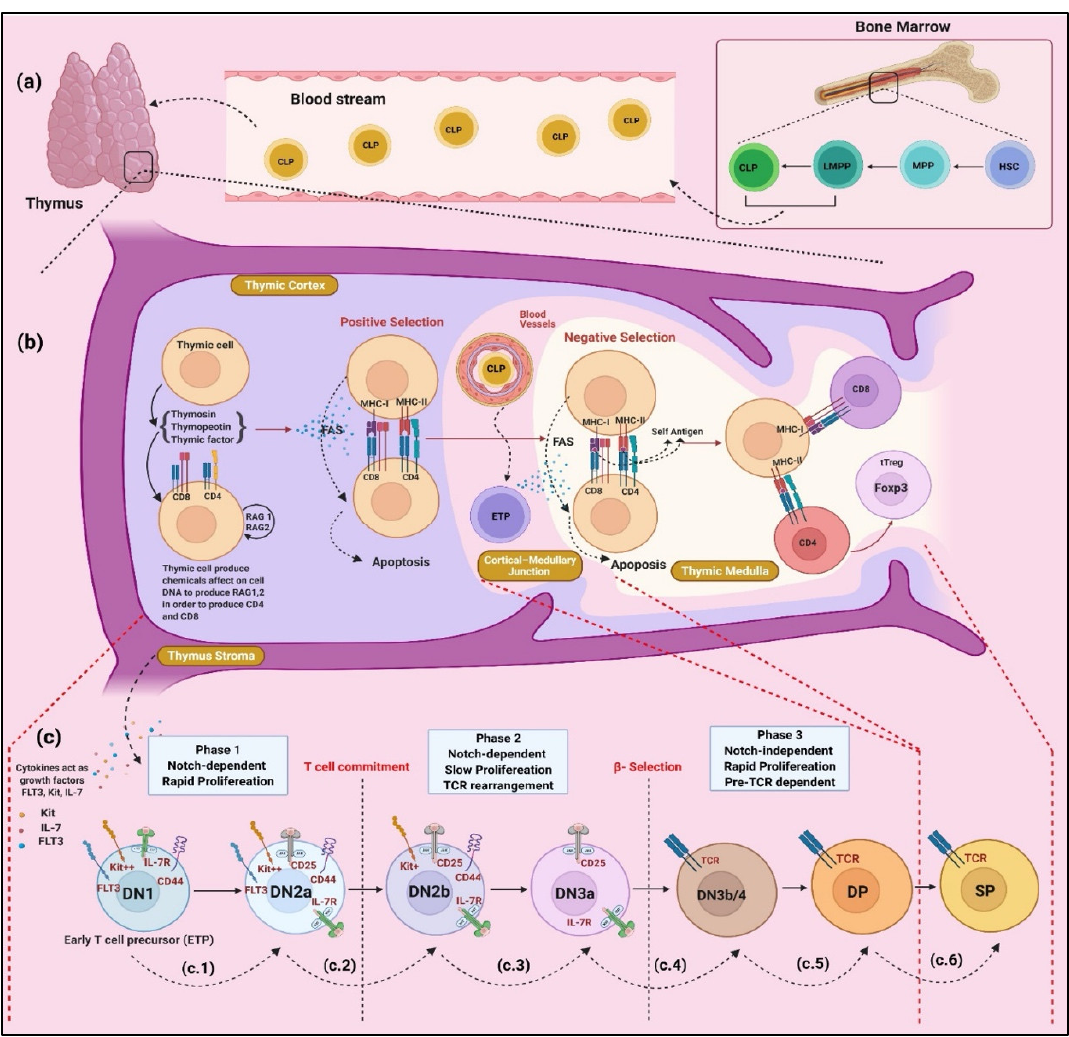
Figure 2. Niche of T cell selection and development. ( a ) In bone marrow (BM) hematopoietic stem cells differentiate to multipotent progenitor (MPP) that subsequently derived to subset called early lymphoid progenitors (ELP) or lymphoid primed multipotent progenitors (LMPP). LMPP differentiate into further downstream developmental stages, common lymphoid progenitor (CLP) that migrates from the bone marrow compartments into thymus through blood stream via the action of chemokines, cell adhesion molecules, and CCL25/CCR9, CCL19-CCL21/CCR7 receptors; ( b ) Cortical DP cells that express αβTCR interacting with MHC molecules presenting on edoncortical thymic epithelial cells (cTECs), receive critical survival signals that are required to further process of differ- entiation. In other words, T cells election and acquisition of MHC restrictions referred to as positive selection. Double positive (DP) cells begin expressing the chemokine receptor CCR7 and migrate to the thymic medulla. In the medulla, TCRs-DP T cells interact with antigen-presenting cells, such as mTECs and dendritic cells, and differentiate into CD4 or CD8 single-positive (SP). The interactions of high-affinity T cells TCRs to self-peptide MHC, normally result in either deleted of autoreactive cells by apoptosis that referred to negative selection or destined to become regulatory T cells through undergoing agonist selections; ( c ) Phases of early T cell development. ETPs in thymus un- dergo three distinct phases based on the status of T lineage commitment and NOTCH dependency; ( c.1 ) Thymus stroma secrets cytokines that act as transcriptional factors include IL-7, FLT3, and cKit. These cytokines initiate the expression of some genes, such as GATA3, Hes1, and Tcf, through acti- vation of NOTCH signalling pathway; ( c.2 ) these genes beside RUNX1 promote expansion of pre- commitment precursor as well as turn on transcriptional repressor Bcl11b in the late DN2a; ( c.3 ) T cell passes from cell commitment and characterized with NOTCH-dependent, slow proliferation and TCR rearrangement. BCL11B turns on leads to c-Kit down-regulation, IL-7R signalling desensi- tization by E proteins, and DN2b cells survival become strictly NOTCH-dependent. E protein-de- pendent genes are recombination activating gene 1 ( Rag1 ), Rag2 , as well as Ptcra (encoding pre-